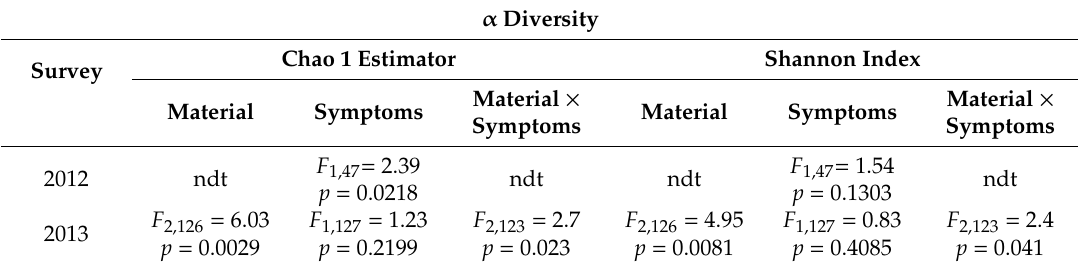
Table 3. Analysis of variance (ANOVA) tables for the alpha diversity of Phytophthora species detected in Extremadura dehesas during the surveys conducted in 2012 and 2013.